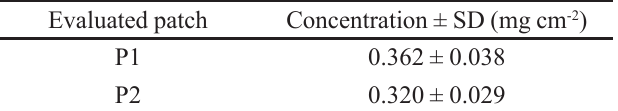
TABLE VI - Amounts of nicotine retained within skin after 24 h of skin permeation studies, n =